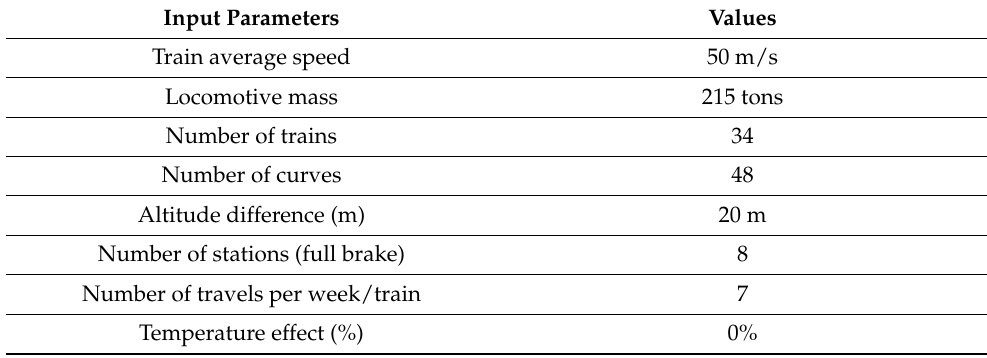
Table 5. Input parameters used in the base case study of electric regenerative braking.